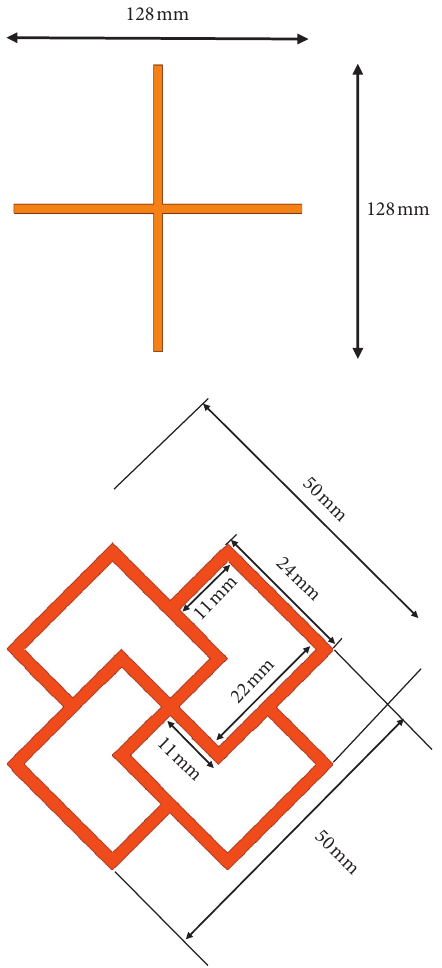
Figure 1: Spatial variation of the antenna radiator.